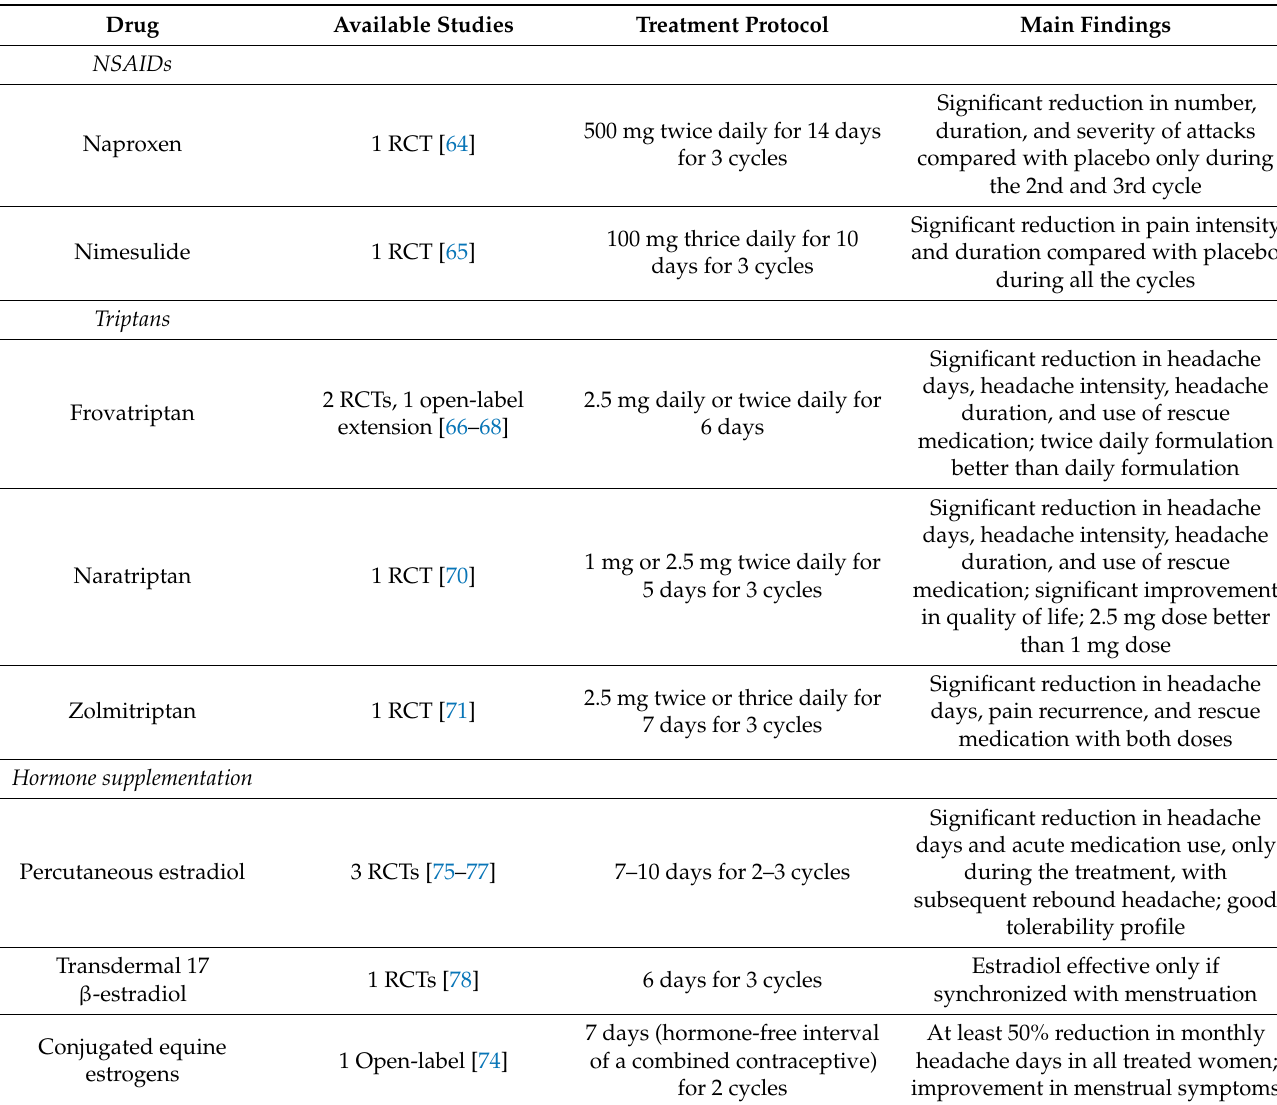
Table 2. Summary of drugs for the short-term prophylaxis of menstrual migraine. RCT indicates randomized controlled trial. Drug Available